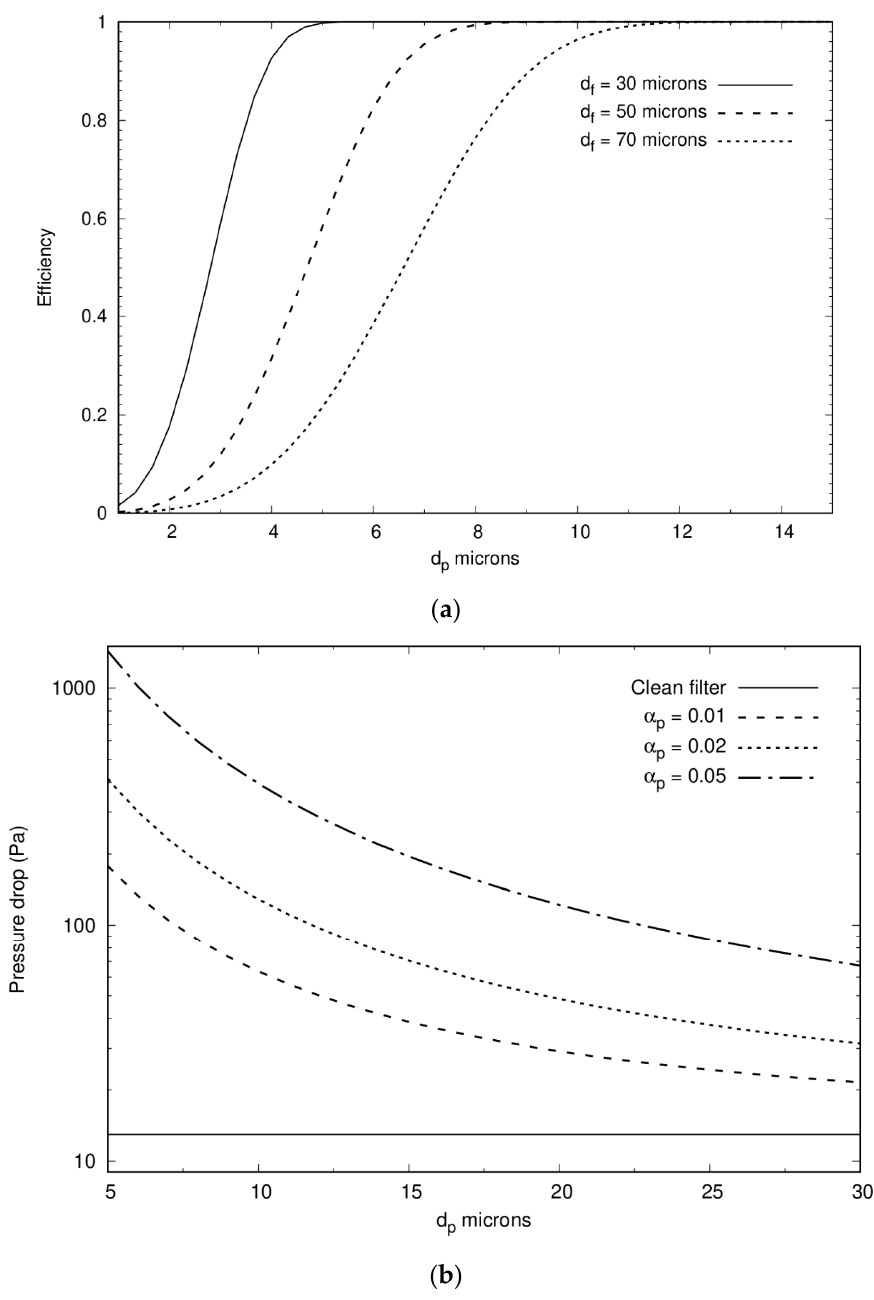
Figure 3. The dust filter’s ( a ) efficiency E for several fiber diameters d f from Equation (3) and ( b ) pressure drop ∆ p for d f = 50 microns and several clogging conditions measured by the particle solidity on the filter α p using Equation (2), where the filter’s solidity is α f =